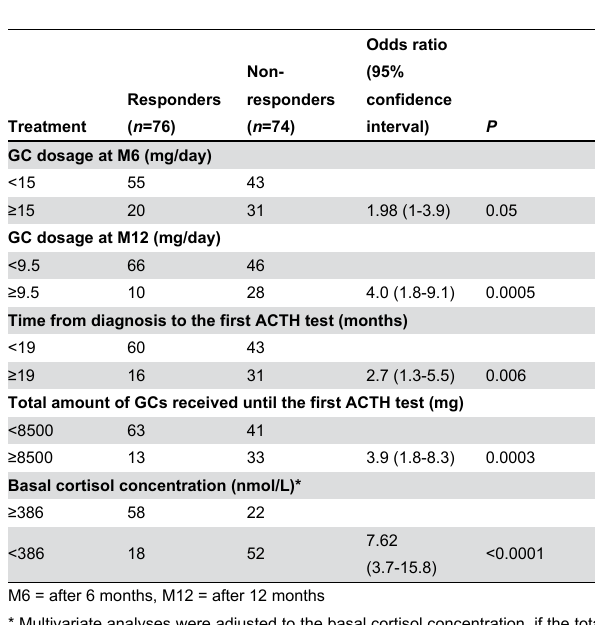
Table 2. Univariate analyses of glucocorticoid (GC) dose and duration in relation to adrenal insufficiency at the first ACTH